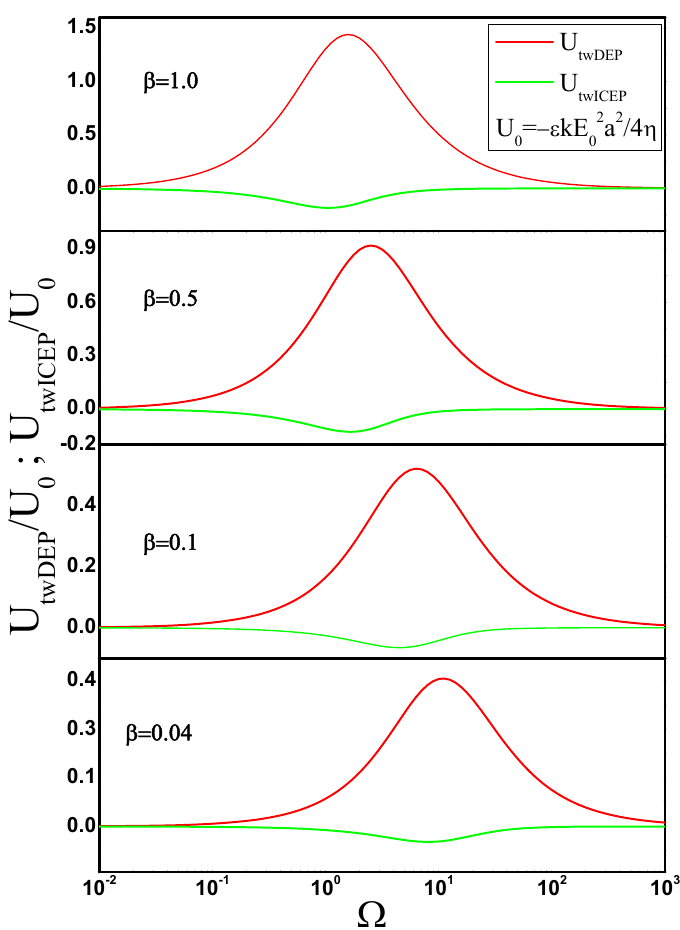
Figure 6. Travelling-wave dipolophoresis of a metal cylinder as a function of angular frequency of the applied ac field. Results are shown for four different values of the cylinder aspect ratio β = b / a . The a 2 /4 η velocity is non-dimensionalized with U 0 = − ε kE 2 0